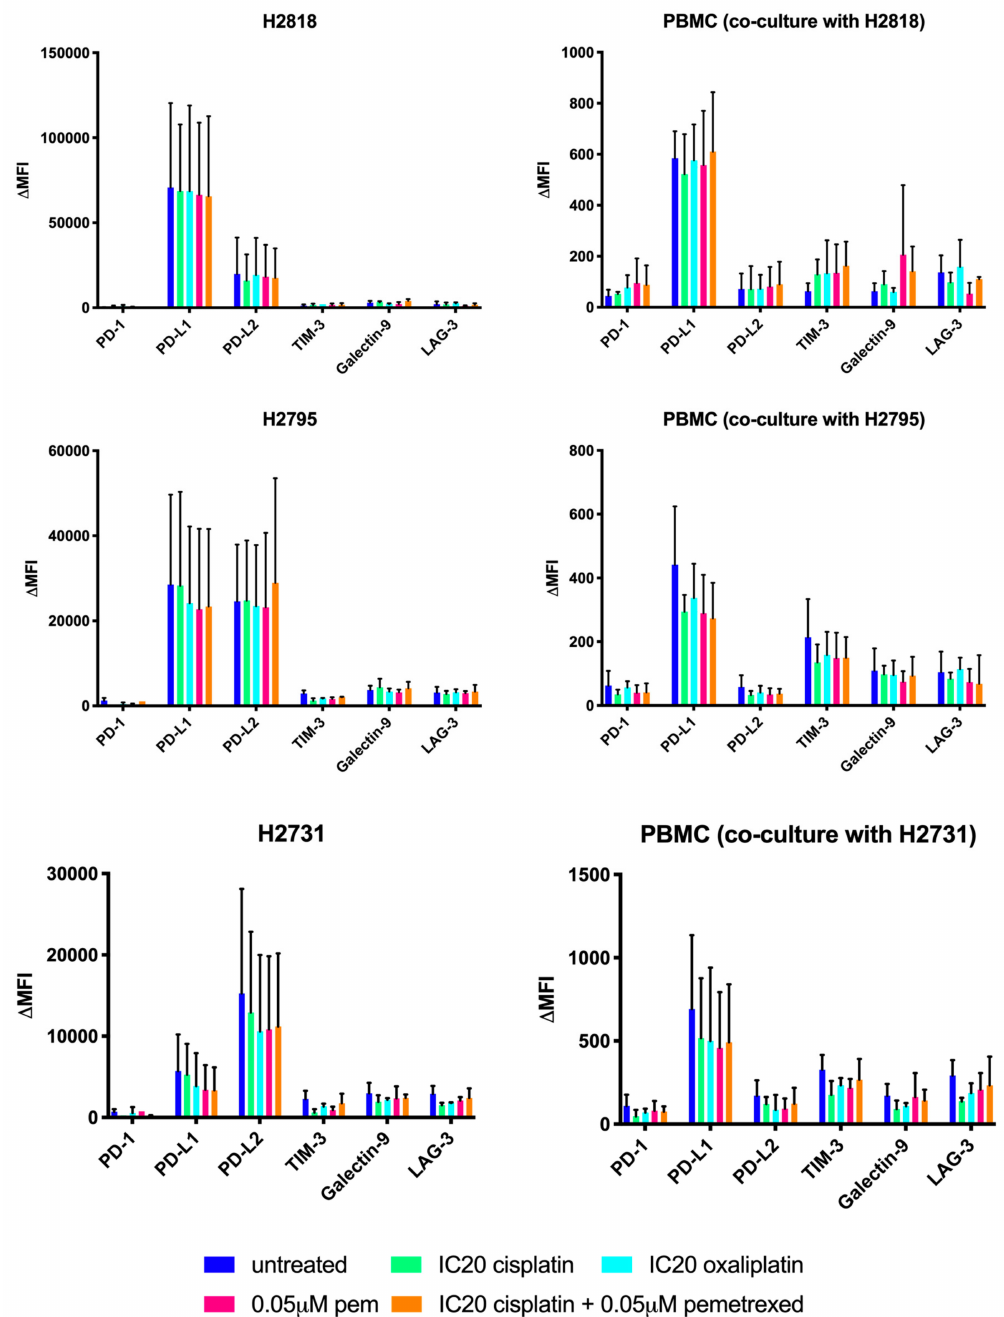
Figure 4. Influence of chemotherapeutics on immune checkpoint expression on MPM cell lines and PBMC in co-culture ( ∆ MFI values). Bar charts of mean ∆ MFI values representing the expression of the immune checkpoints or ligands on NCI-H2818, NCI-H2795, NCI-H2731 and corresponding PBMC. Expression is determined after treatment. Error bars represent the standard deviation ( n = 3). p < 0.05: significant di ff erence in immune checkpoint or ligand expression. Isotype controls were used to consider aspecific binding of the flow cytometry